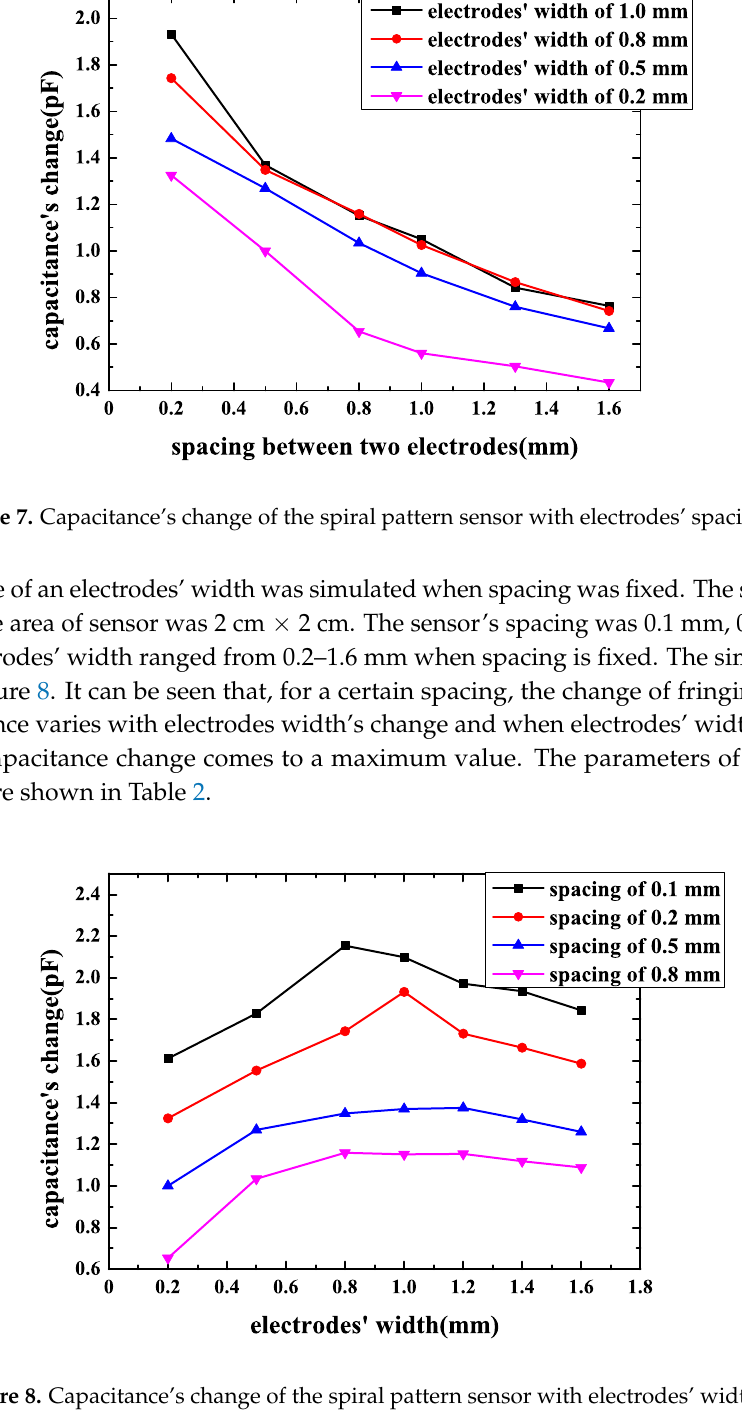
Figure 8. Capacitance’s change of the spiral pattern sensor with electrodes’